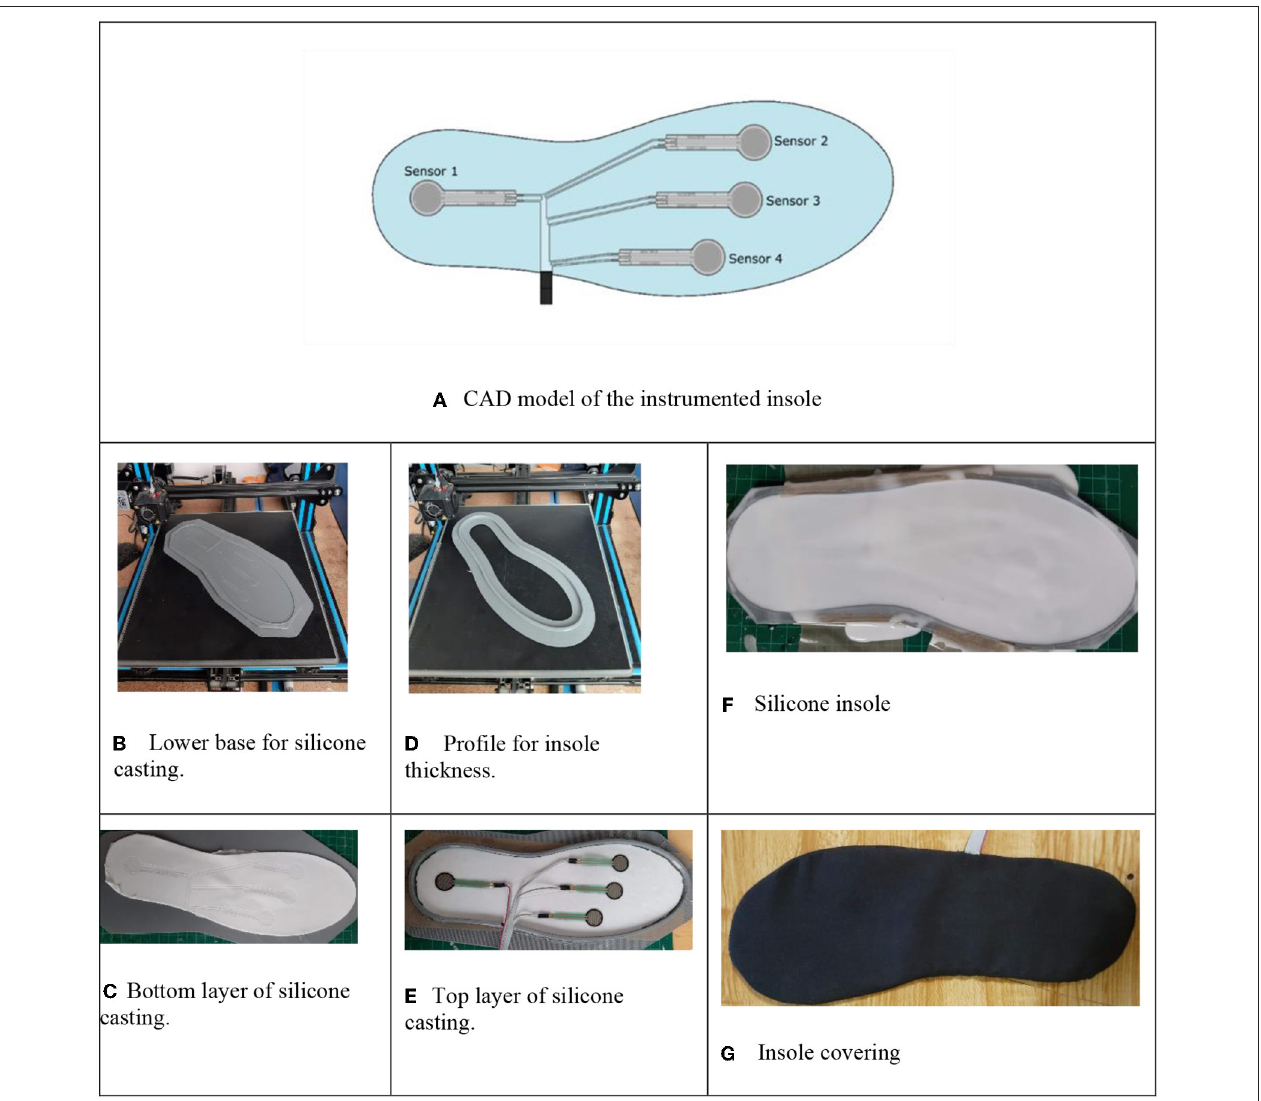
FIGURE 3 | Instrumented insole, CAD design, and manufacturing. (A) CAD model of the instrumented insole. (B) Lower base for silicone casting. (C) Bottom layer of silicone casting. (D) Profile for insole thickness. (E) Top layer of silicone casting. (F) Silicone insole. (G ) Insole